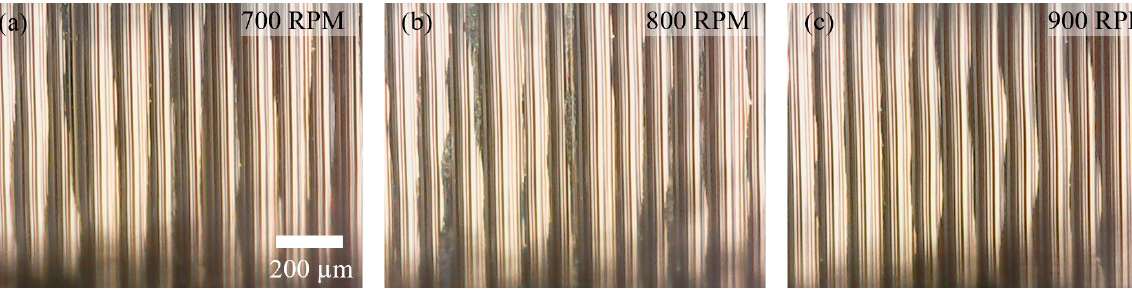
Figure 7. Turning machining experiment setup.